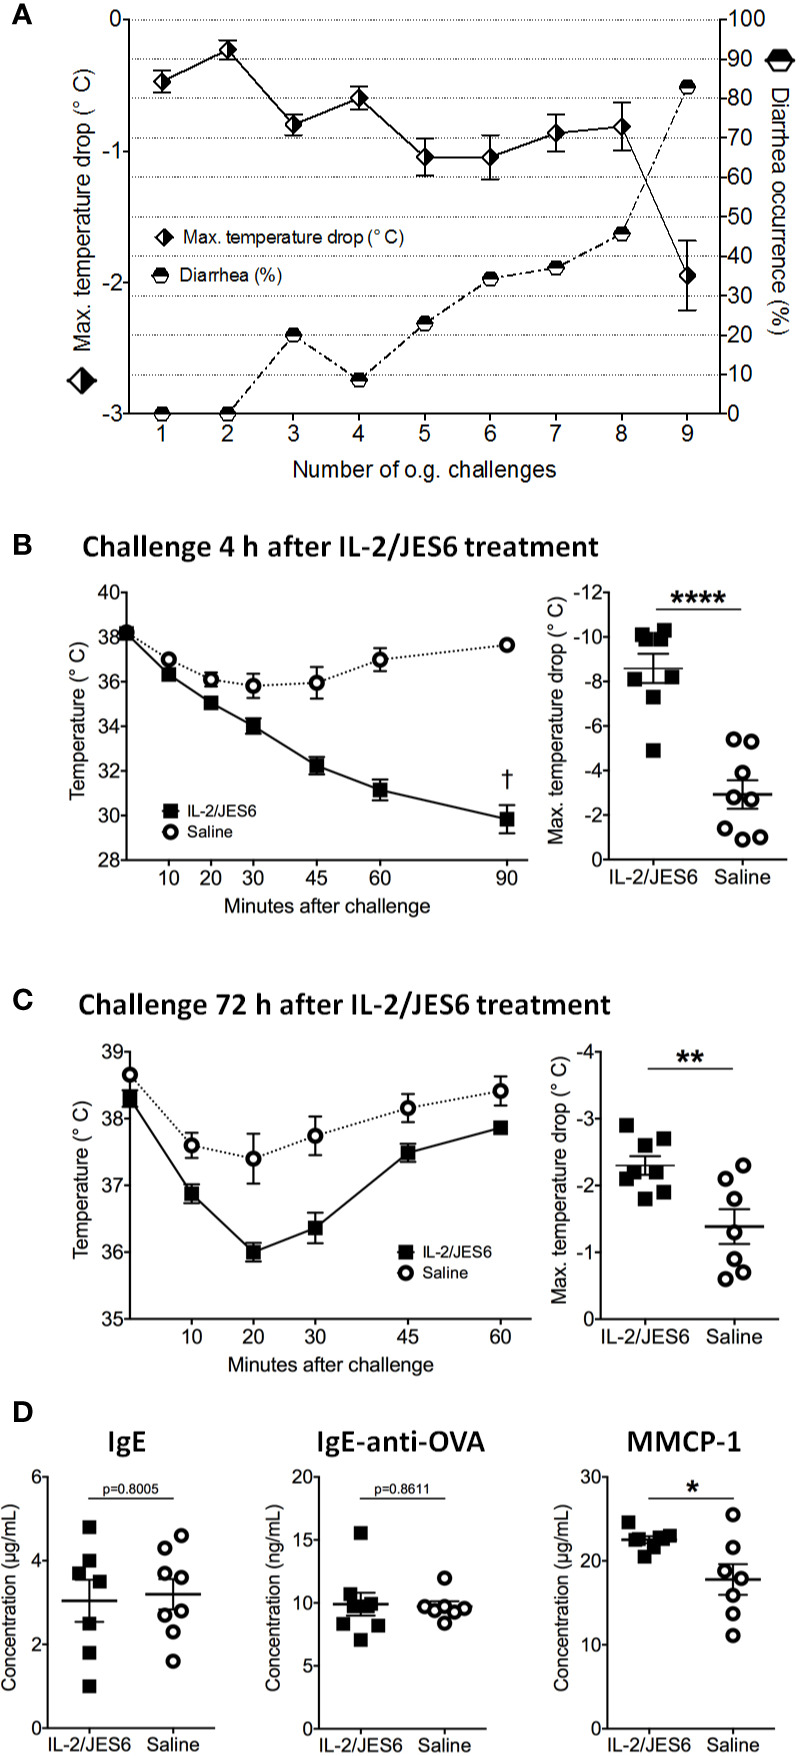
Therapeutic IL-2/JES6 treatment. Sensitized and repeatedly challenged mice were treated with IL-2/JES6 either four or 72 h before the final allergen challenge. (A) Hypothermia and diarrhea following allergen challenges, before IL-2/JES6 administration. (B) Rectal temperature curve (left) and maximal temperature drop (right) of mice treated with IL-2/JES6 4 h before allergen challenge. (C) Rectal temperature curve (left) and maximal temperature drop (right) of mice treated with IL-2/JES6 at 72 h before allergen challenge. (D) Total IgE, ovalbumin (OVA)-specific IgE and IgG1 and MMCP-1 in serum measured by ELISA (after challenge 13, 72 h after the last IL-2/JES6 treatment). Data depicted represent mean ± SEM (A: n = 35, (B–D) n = 7 8). *p < 0.05, **p < 0.01, ****p < 0.0001 (Student’s t-test).